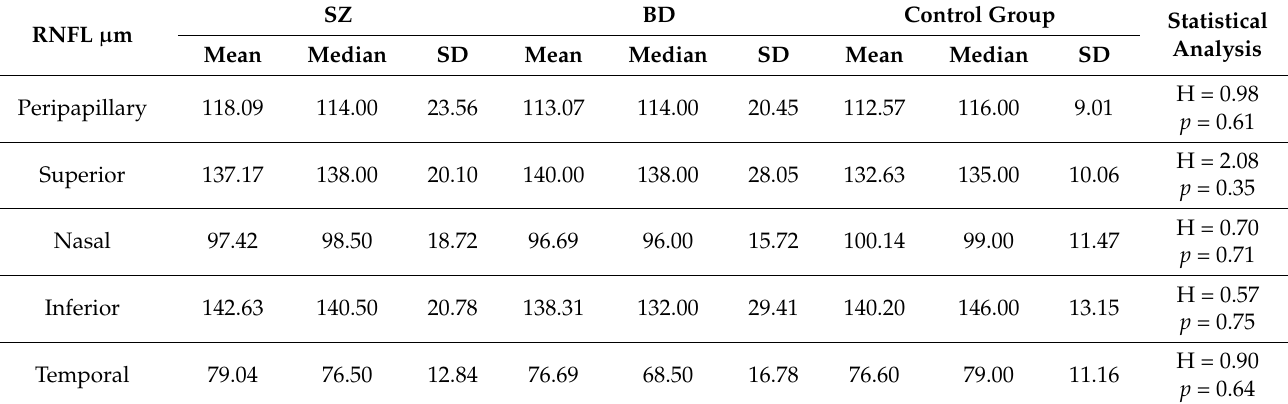
Table 2. RNFL parameters in the optic nerve disc area in the eyes of the SZ and BP patients and in the control group. RNFL µ